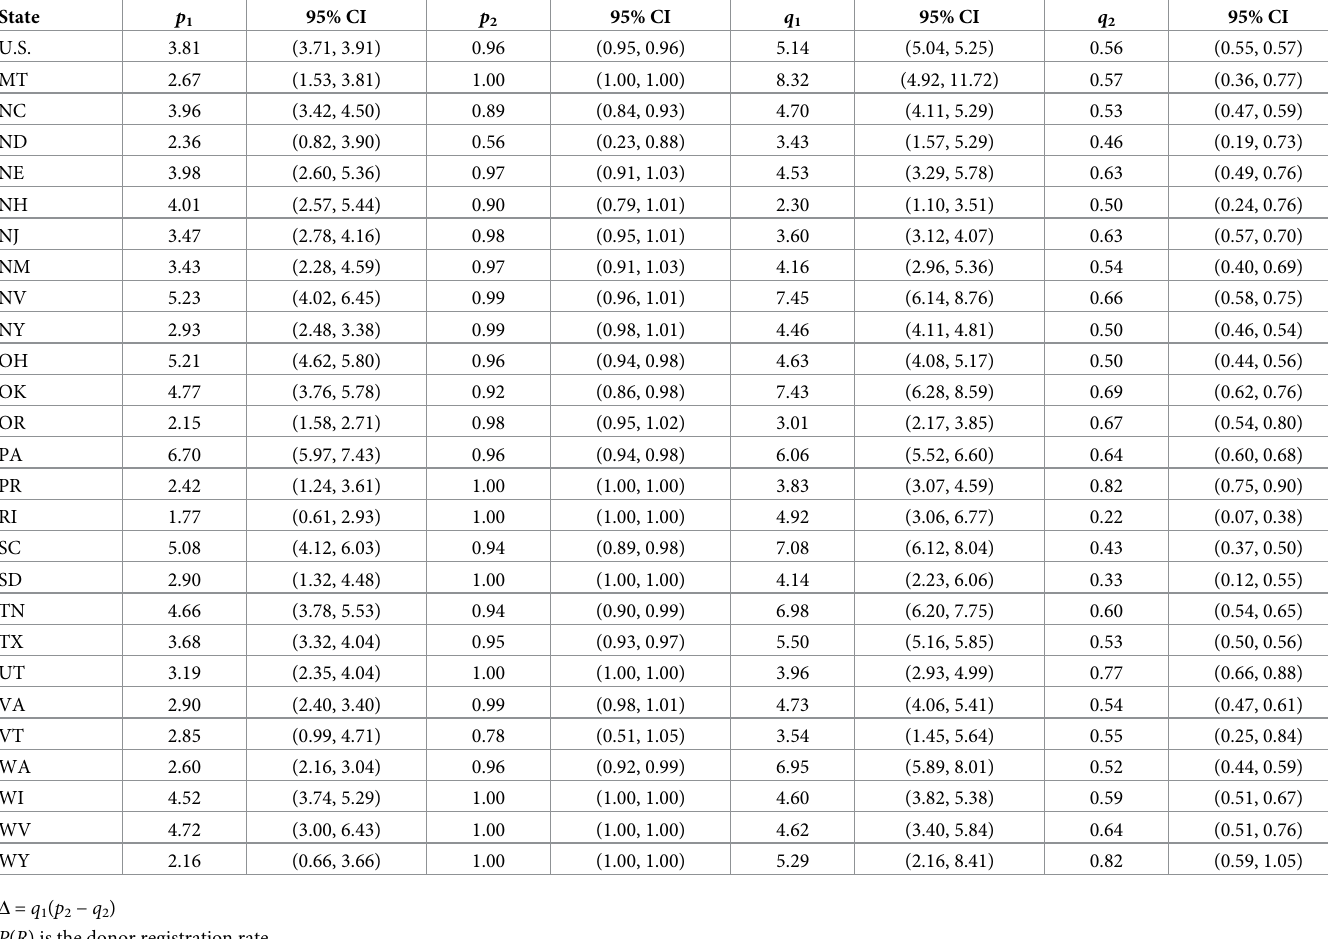
Table 5. Confidence intervals for p 1 , p 2 , q 1 , and q 2 ,